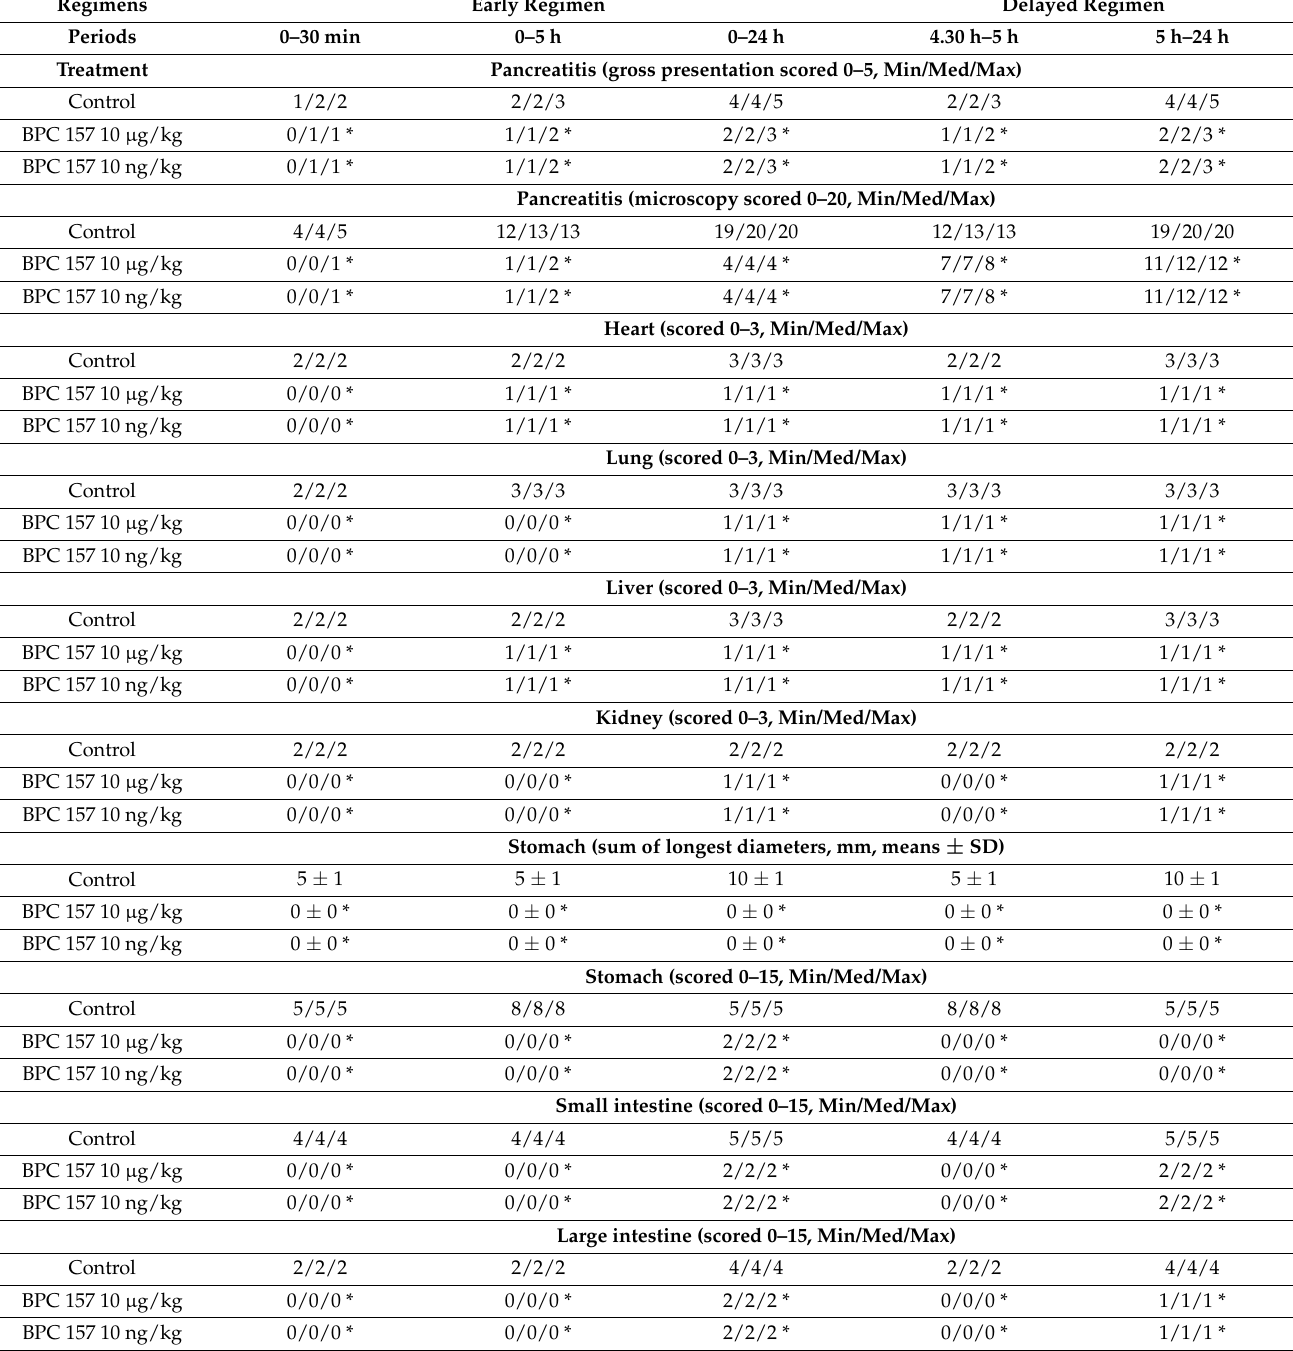
Table 1. Pancreatitis, heart, lung, liver, kidney, stomach, small and large intestine lesion assessment in the bile duct-ligated rats following ligation (time 0) at sequential periods (application sacrifice) to illustrate the effect of both early treatment and delayed treatment following ligation. * p < 0.05, at least, vs.